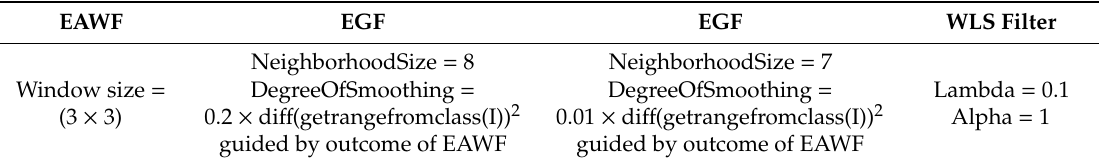
Table 1. Present the simulation conditions for the proposed method.